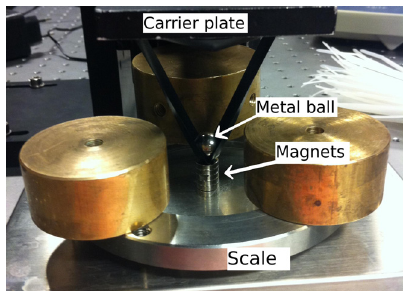
Fig. 3. The measurement setup for the force applied by magnets on a single steel ball. The ball is suspended above the magnets, which are attached to weights. The reciprocal force working on the magnets reduce the weight displayed on the scale, allowing for calculation of the magnetic force as a function of the difference in displayed weight. Themethod by which the ball was suspended in this image is the one we used for very small distances ( d < 3mm) between theball and the magnets.